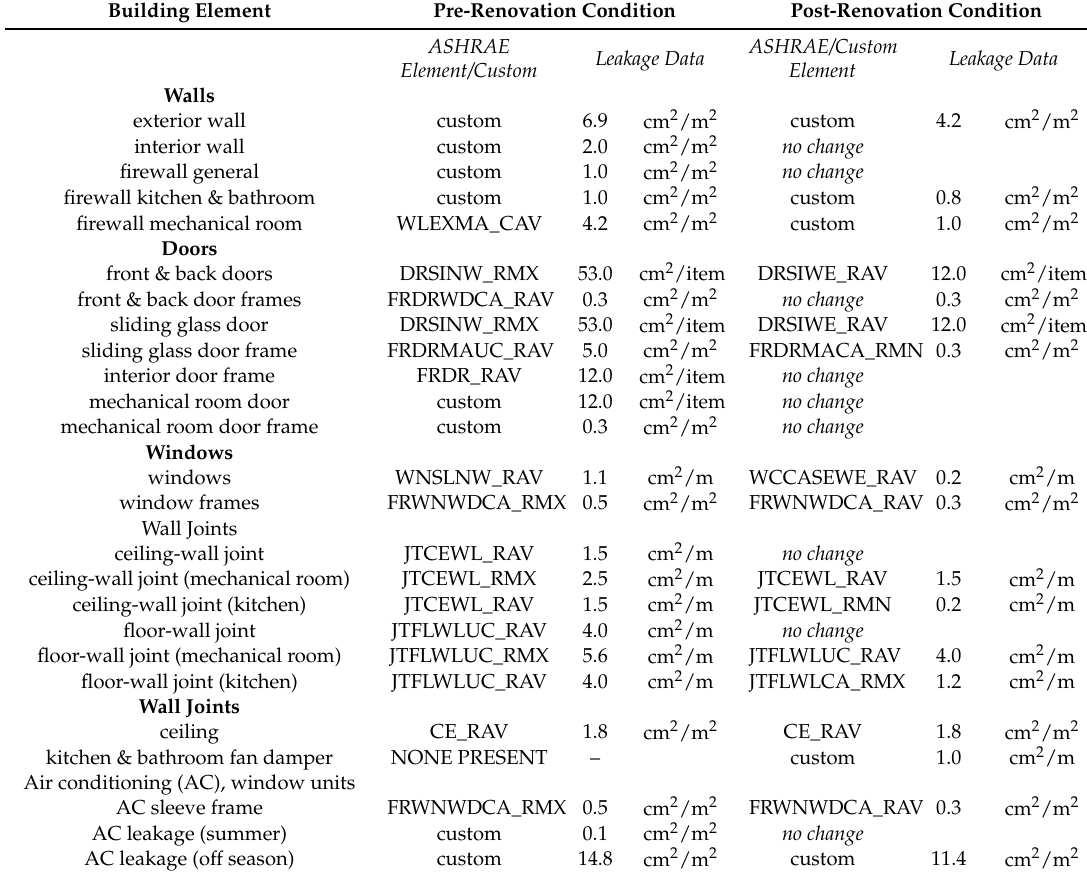
Table A2. Building elements and corresponding leakage values used to construct the CONTAM townhouse building template pre and post a deep energy building